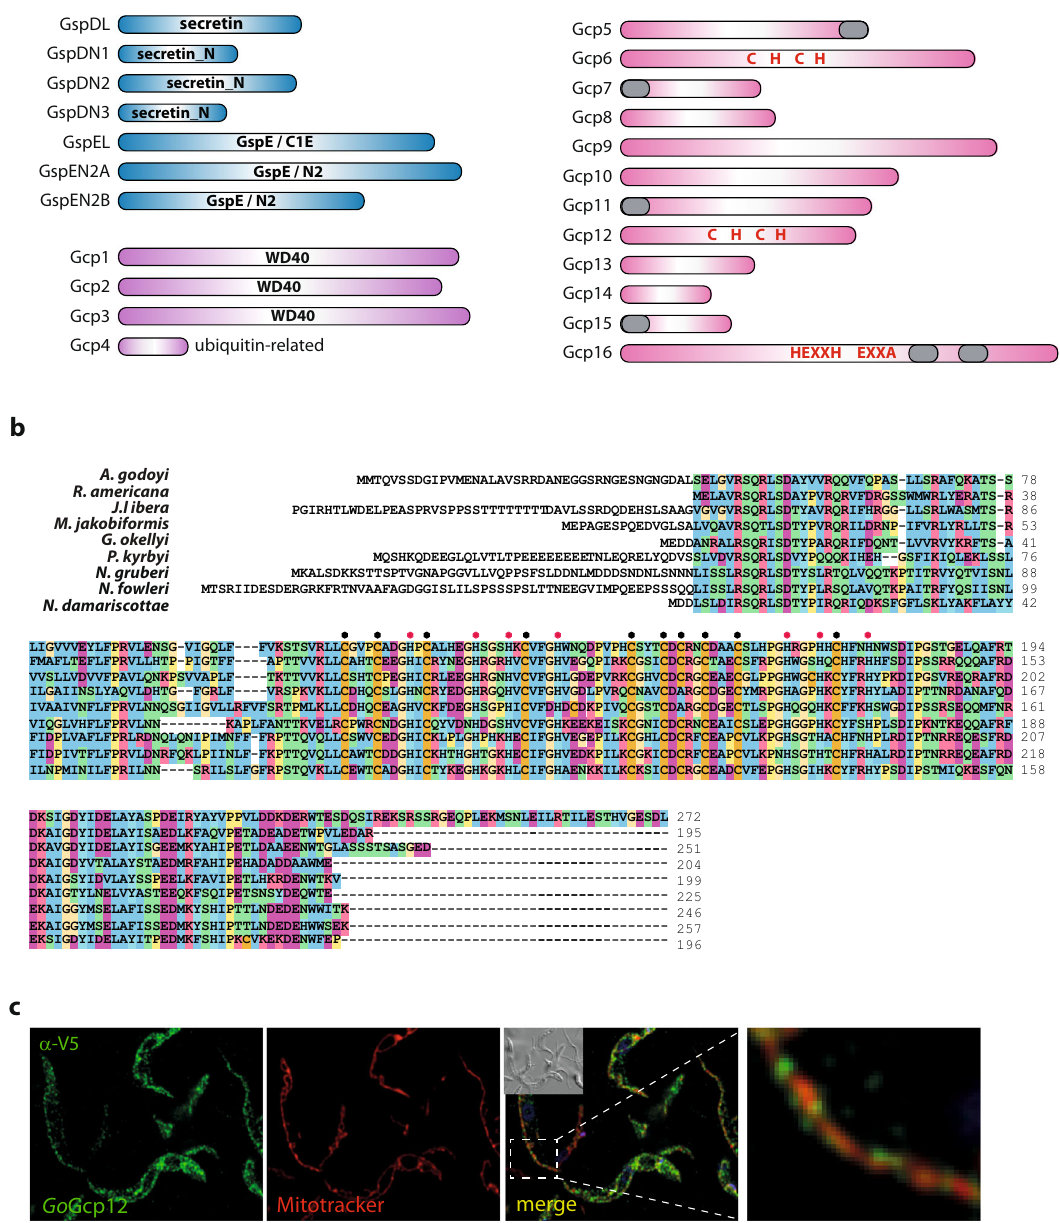
Fig. 8 Proteins with the same phylogenetic pro fi le as the originally identi fi ed mitochondrial Gsp homologues. a Schematic domain representation of 23 proteins occurring in heteroloboseans, jakobids and malawimonads with the core T2SS subunits but not in other eukaryotes analyzed. Proteins with a functional link to the T2SS suggested by sequence homology are shown in blue, proteins representing novel paralogues within broader (super) families are shown in violet, and proteins without discernible homologues or with homologues only in prokaryotes are shown in pink. The presence of conserved protein domains or characteristic structural motifs is shown if detected in the given protein. Grey block – predicted transmembrane domain (see also Supplementary Fig. 11); “ C H C H ” – the presence of absolutely conserved cysteine and histidine residues (see also Supplementary Fig. 12) that may mediate binding of a prosthetic group; “ HEXXH ” and “ EXXA ” in Gcp16 indicate absolutely conserved motifs suggesting that the protein is a metallopeptidase of the gluzincin group (see text). The length of the rectangles corresponds to the relative size of the proteins. b Protein sequence alignment of Gcp12 proteins with highlighted conserved cysteine (black circles) and histidine (red circles) residues. c The expression of Go Gcp12 in T. brucei with the C-terminal V5 tag (green) showed partial co-localisation with the mitochondrion (red) (representative image of three experiments is shown). Scale bar 10 µ